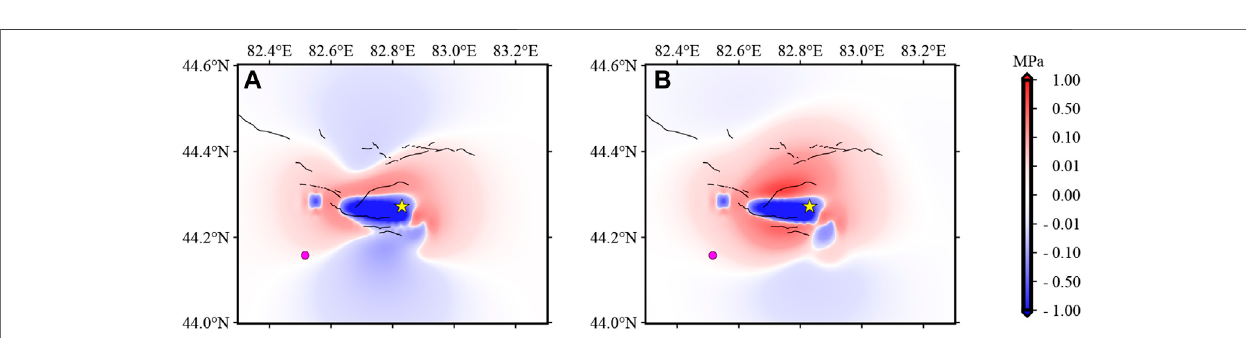
Frontiers in Earth Science |